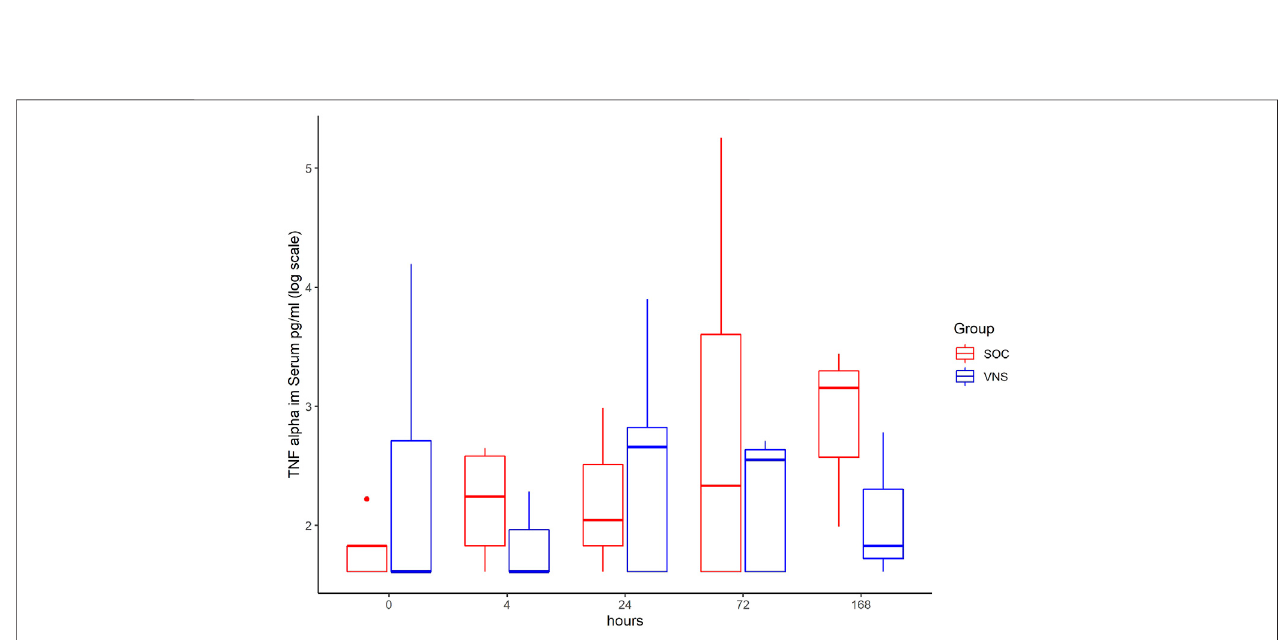
FIGURE 2 | Median TNF alpha level with Interquartile Range of patients receiving auricular Vagus Stimulation (VNS = blue) and patients only receiving Standard of Care (SOC = red) after 0, 4, 24, 72, and 168 h of study inclusion.